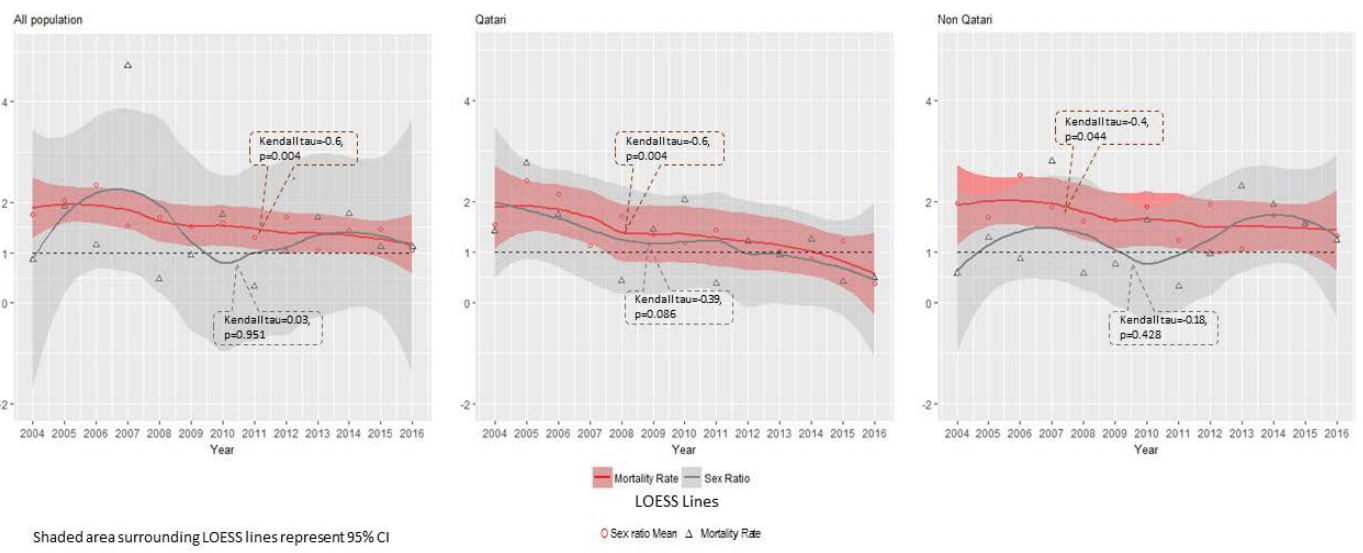
Figure 1. Annual rate and sex ratio of childhood mortality in Qatar by nationality by nationality and sex in Qatar from 2004 to 2016. The mortality trends and characteristics among infants under one year of age in Qatar have already been discussed in our previous publication.